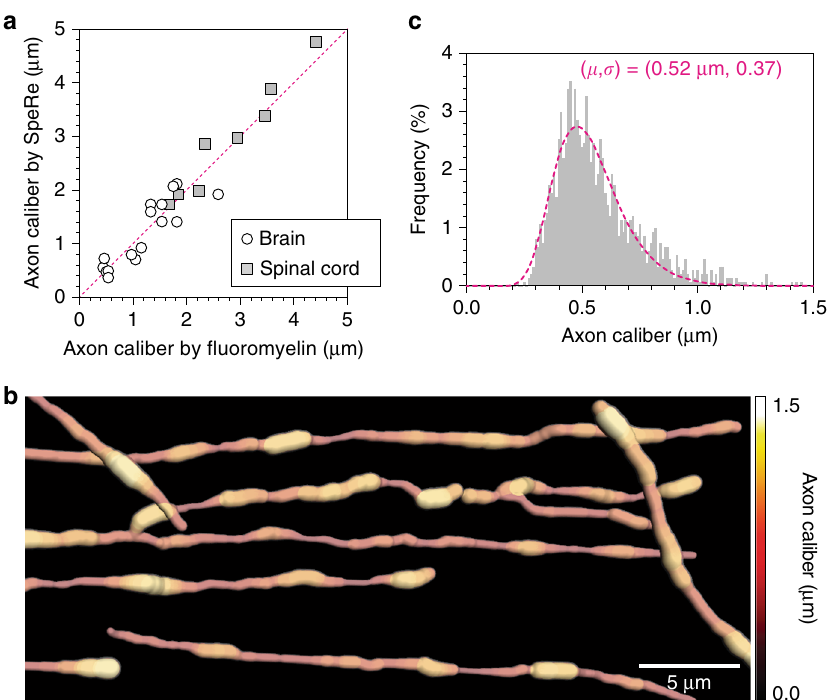
Fig. 4 Nanoscale mapping of axon caliber. a Validation of axon caliber, as measured by SpeRe. Diameters of axons from the brain ( n = 16) and the spinal cord ( n = 8) were quanti fi ed using both SpeRe and a fl uoromyelin-based method. The red dotted line indicates the unity line ( R 2 = 0.93). b A nanoscale volumetric view of the axon. The image stack (xyz λ ) is skeletonized and rendered using the axon diameter extracted from wavenumber period ~ ν p ð Þ for each pixel on the skeleton. Myelin is not shown. c Probability density function of axon diameter acquired from b . The diameter is quanti fi ed for each 1.2 μ m axon segment. The dotted line indicates the best fi t to log-normal distribution (geometric mean = 0.52 μ m, geometric standard deviation = 0.37)